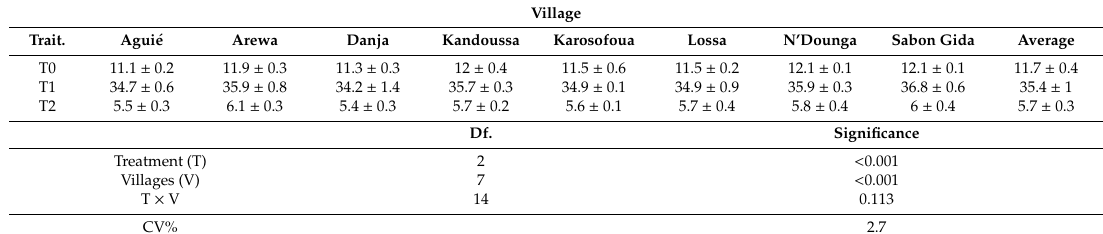
Table 3. E ff ect of the treatments on time use for sowing and fertilizer application in the eight villages (h ha − 1 ). Averages of treatments and corresponding 95% confidence intervals are presented. Trait.